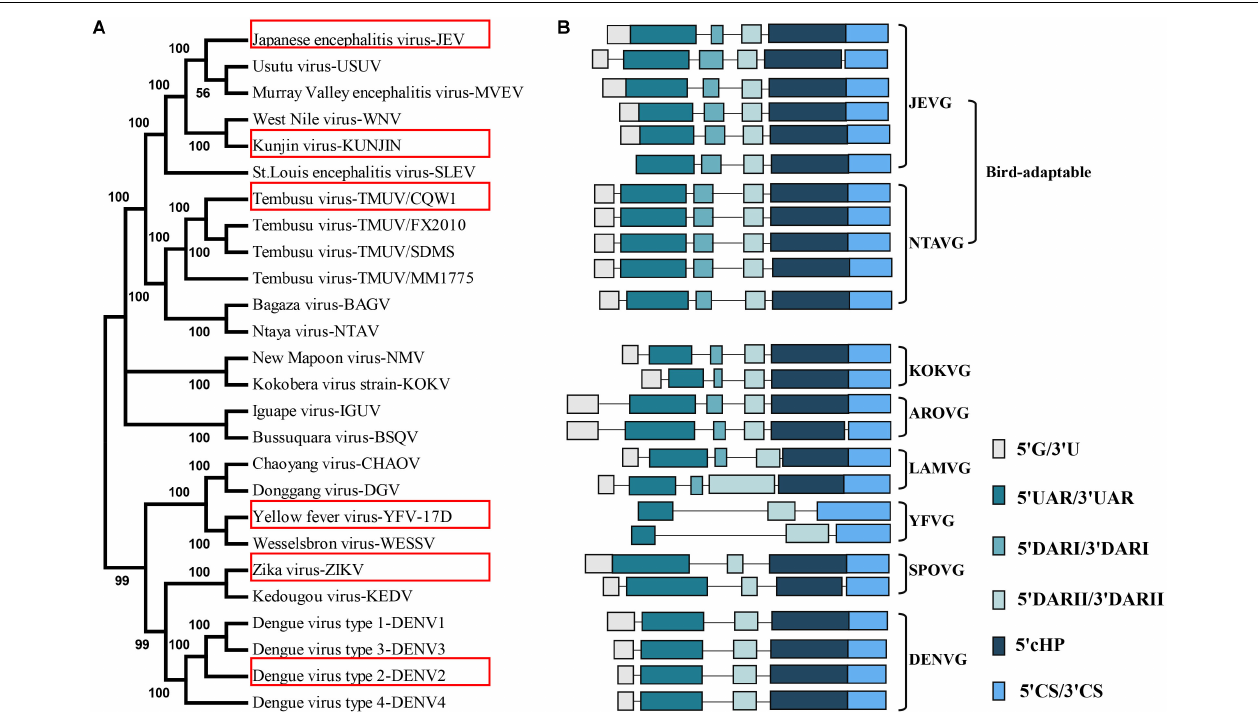
FIGURE 1 | Mosquito-borne flaviviruse genome phylogenetic analysis and schematic depiction of the common structural architecture of 5 (cid:48) -3 (cid:48) cirRNA. (A) The maximum-likelihood phylogenetic tree of the MBFVs. Based on the complete-coding-sequence nucleotide alignments, the phylogenetic tree was constructed in MEGA6 with the representative MBFVs in the red box. (B) Structure schematic of the cyclization elements, highlighting the eight MBFVGs and the bird-adaptable MBFVG. The cyclization schematic diagram of NTAV species is lacking because its 3 (cid:48) cis- acting RNA isn’t registered in NCBI. Each element is proportionally scaled and presents as corresponding